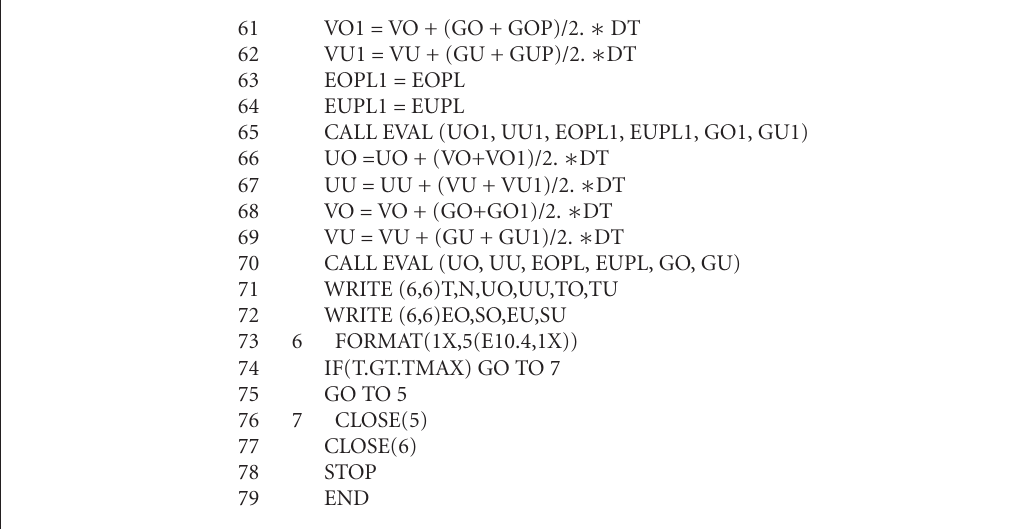
Algorithm 1: MAIN program.